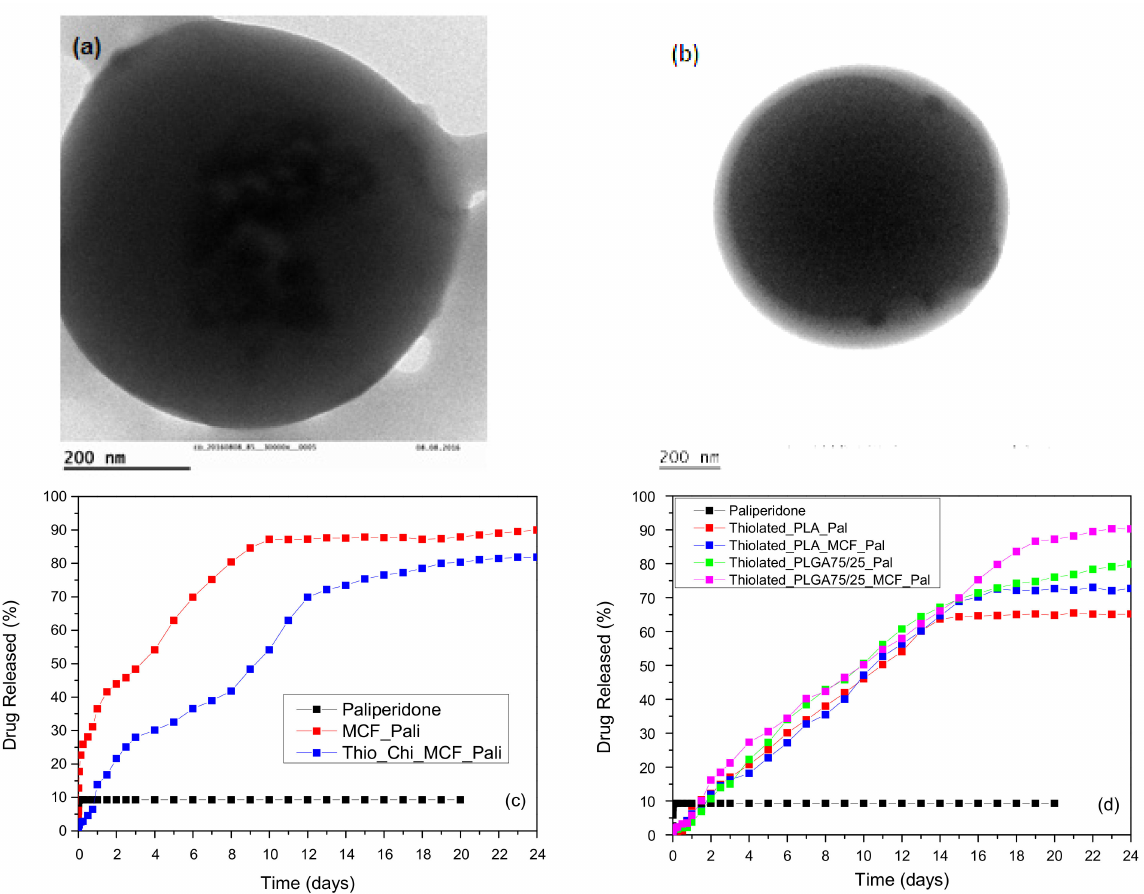
Figure 5. TEM images of microspheres: ( a ) Thiolated_PLA_MCF_Pal and ( b ) Thiolated_PLGA75/25_ MCF_Pal and dissolution profile of ( c ) neat paliperidone, MCF loaded drug and thiolated CS mi- crospheres, and ( d ) drug release profile from PLA- and PLGA-coated microspheres with thiolated chitosan